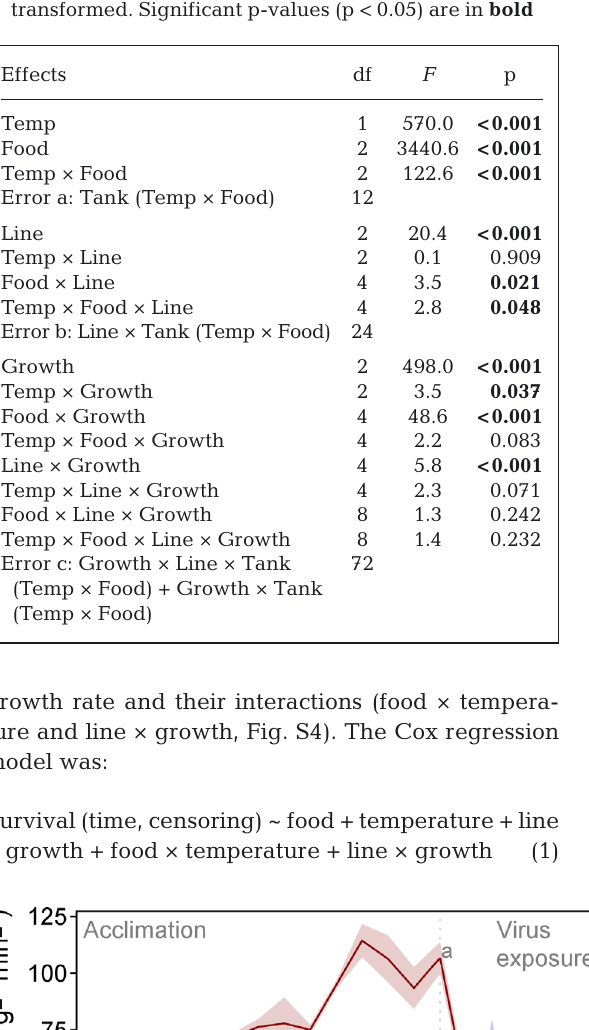
Table 1. Summary of generalized linear mixed-effects model to assess the effects of temperature (Temp, 16.5 vs. 22°C), food level (starved, low and high), line (G0, G1 and G2) and growth (fast, medium, slow) on growth rate of Pacific oysters